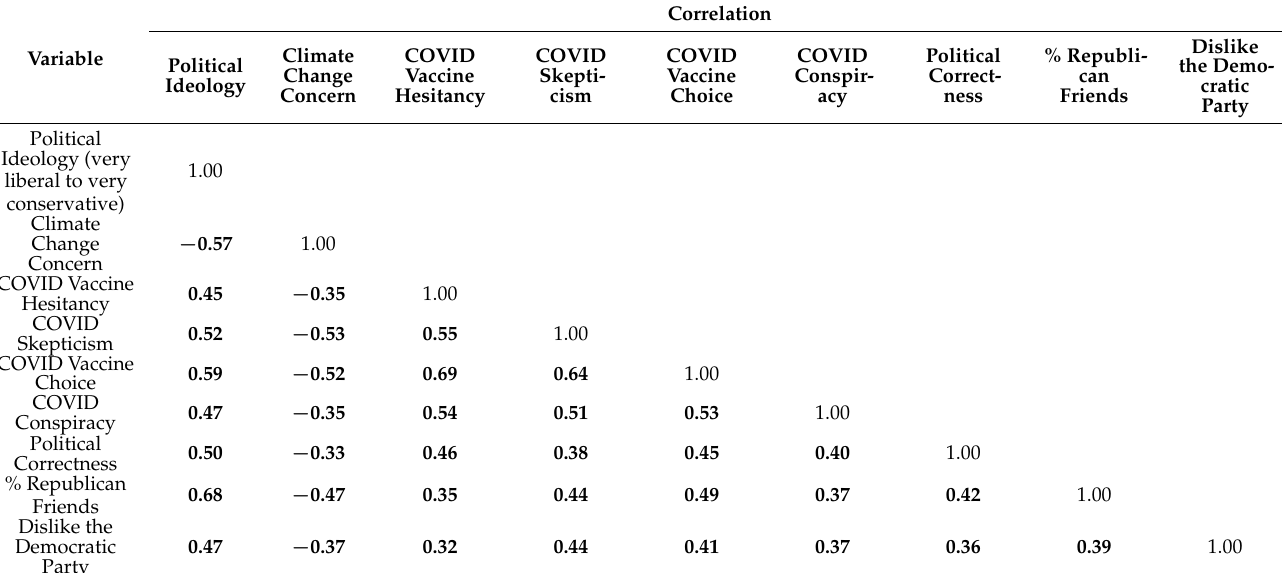
Table 2. Correlation matrix of COVID vaccination, climate change, and political attitudes and behaviors at wave 7. Bold = p <